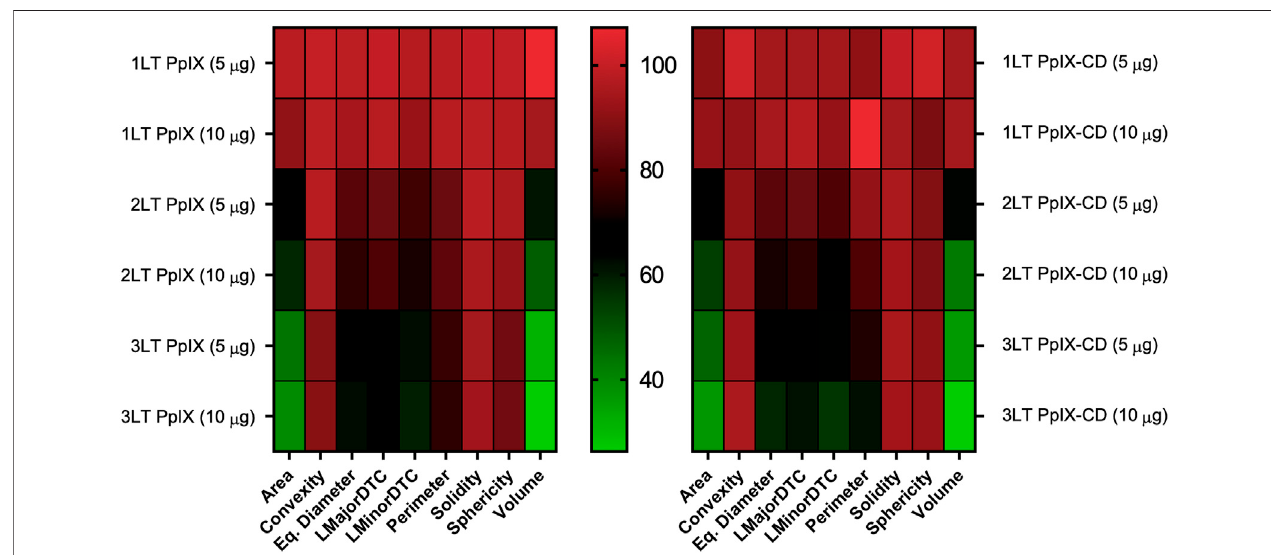
FIGURE 4 | Variability in spheroid morphology at 24 h post-PDT. Parameters are compared to untreated spheroids, shown as 100% of each value. Each square corresponds to nine independent repeats. Area and volume show the greatest variations between PDT treatment conditions in both PpIX and PpIX-CD, followed by diameter-related parameters. Spheroid roundness (convexity, solidity, sphericity) did not show high variation after photoinduced damage. ( N (cid:1) 3, n (cid:1)